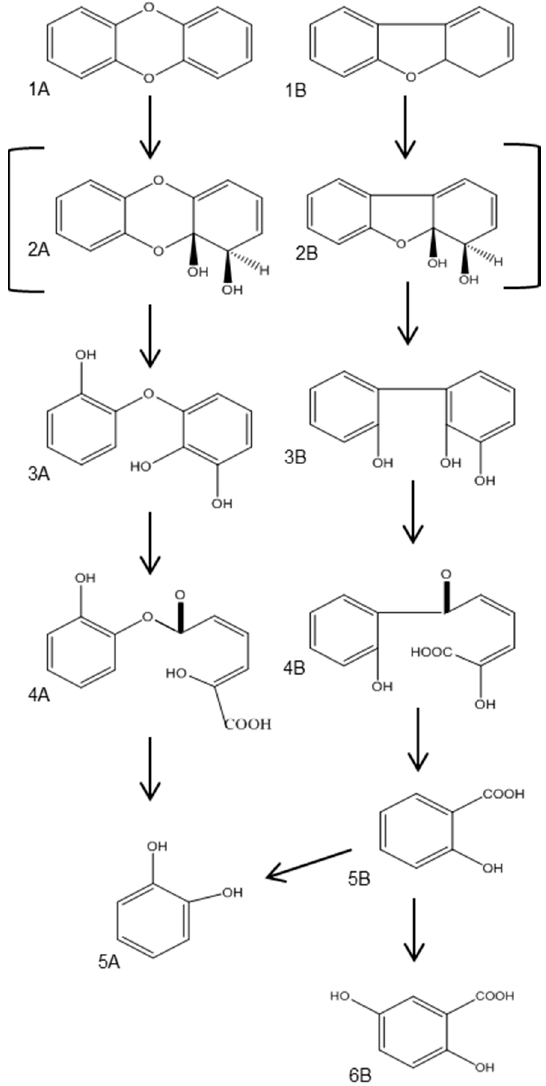
Figure 5. Degradation pathway of dibenzo- p -dioxin ( 1A ); and dibenzofuran ( 1B ) [56,62,65,66,68–70].